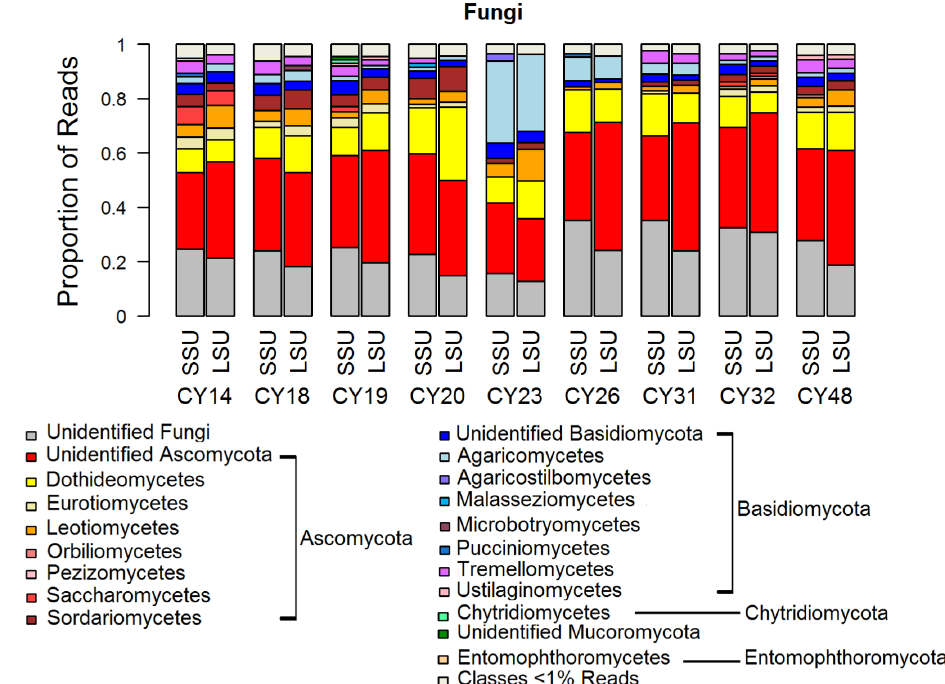
Figure 2. Taxonomic composition of Fungi. Taxonomic classification and proportion of SSU and LSU reads of Fungi at the class level.